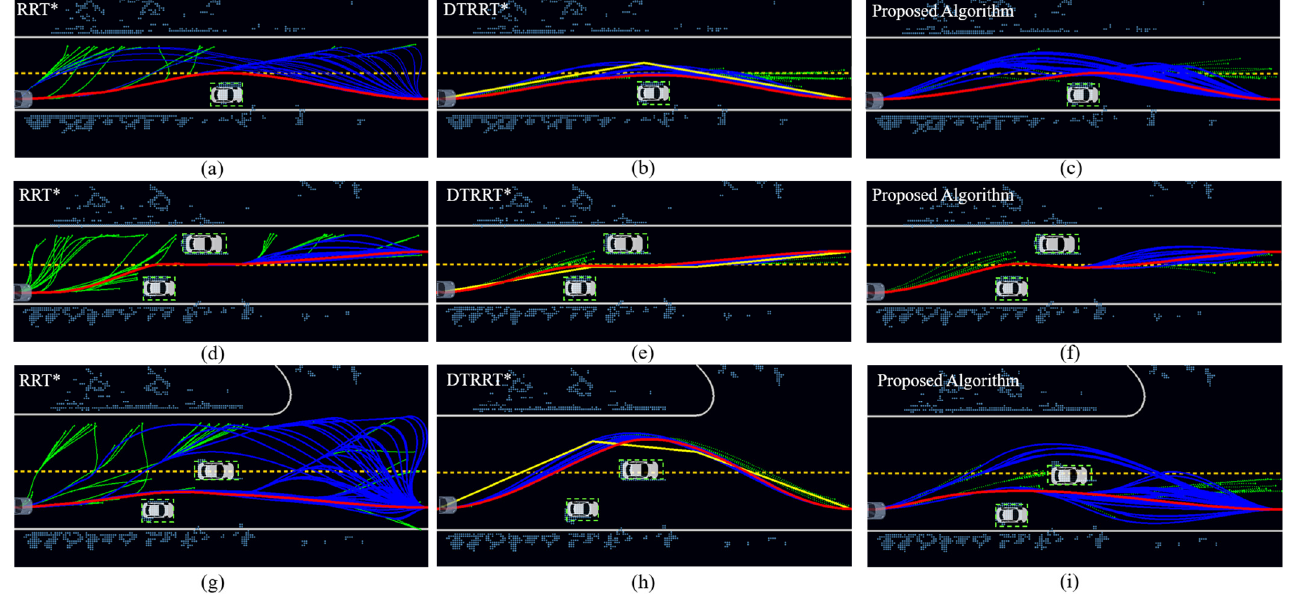
Figure 17. Results of node optimization experiments, where ( a – c ) are Scene 1, ( d – f ) are Scene 2, and ( g – i ) are Scene 3; ( a , d , g ) are the results of the RRT* algorithm; ( b , e , h ) are the results of the DT-RRT* algorithm; and ( c , f , i ) are the results of the proposed algorithm.